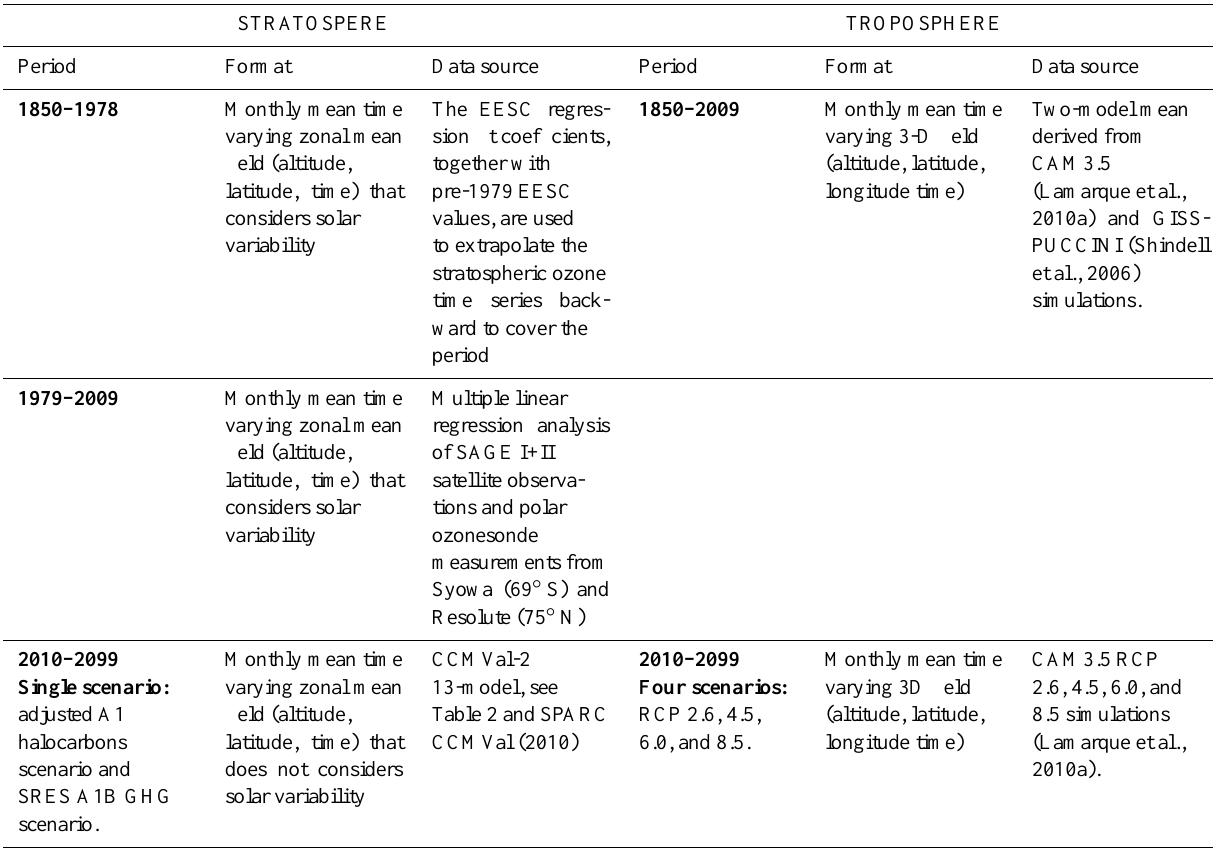
Table 1. Summary of data sources used in the AC&C/SPARC ozone